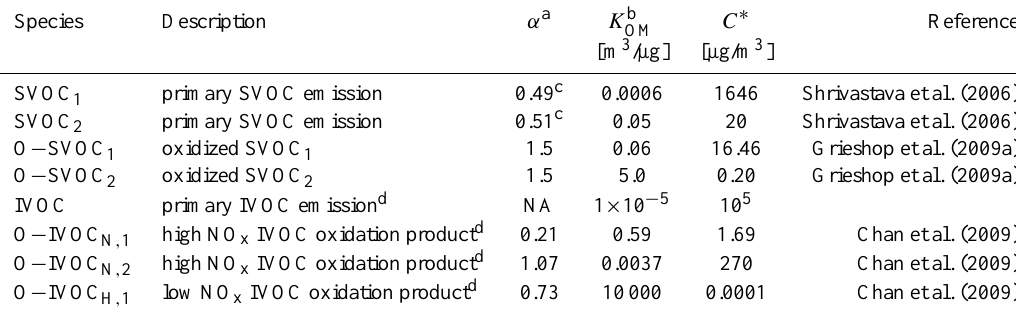
Table 1. Low-volatility organic compounds.